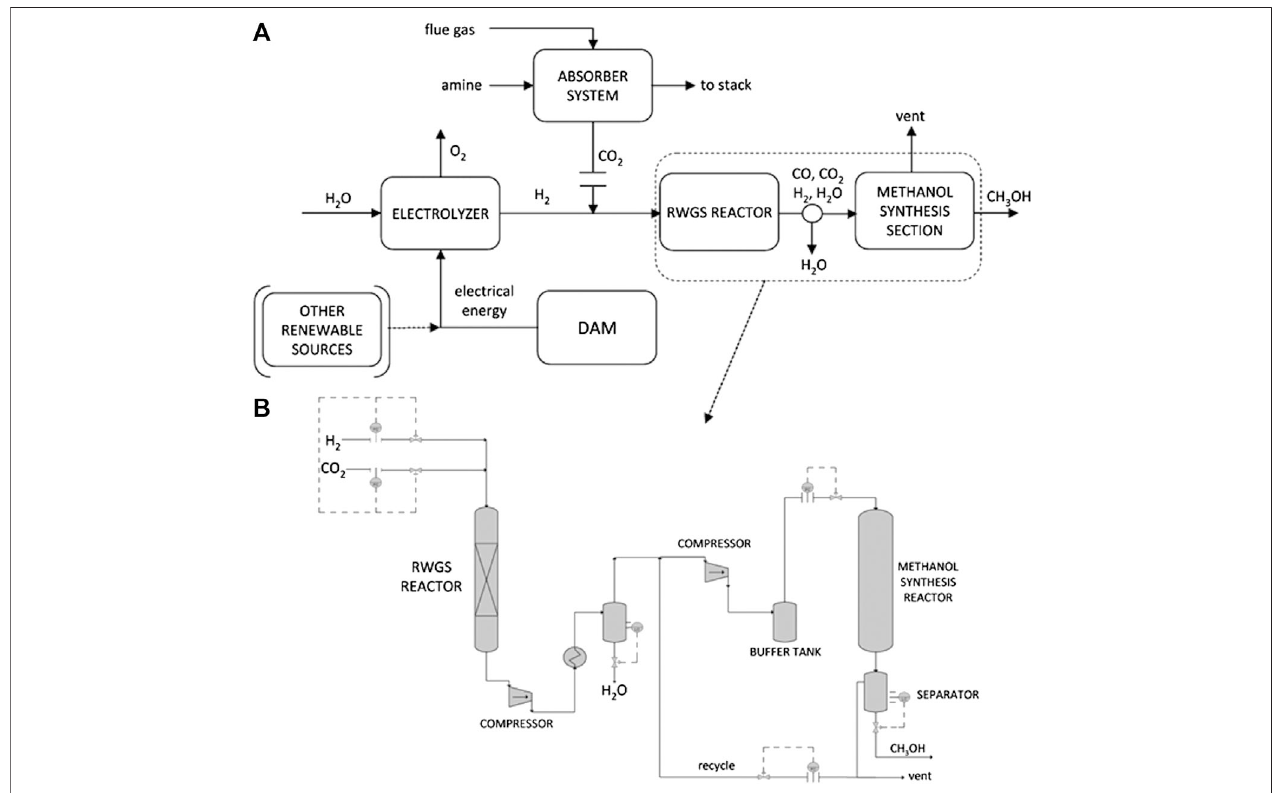
FIGURE 3 | A ) Simpli fi ed block diagram of different material fl ows participating in the process of methanol synthesis from CO 2 and renewable H 2 . ( B ) Simpli fi ed fl owsheet for the section of the RWGS reactor and methanol synthesis system. Reproduced with permission from Barbato et al. (2014).